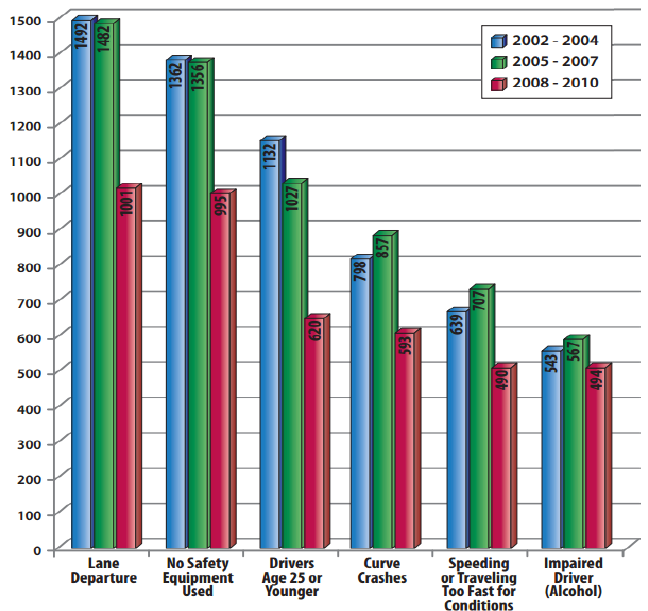
Figure 1: Wyoming’s critical crashes (Incapacitating injury and fatal) 2002 – 2010